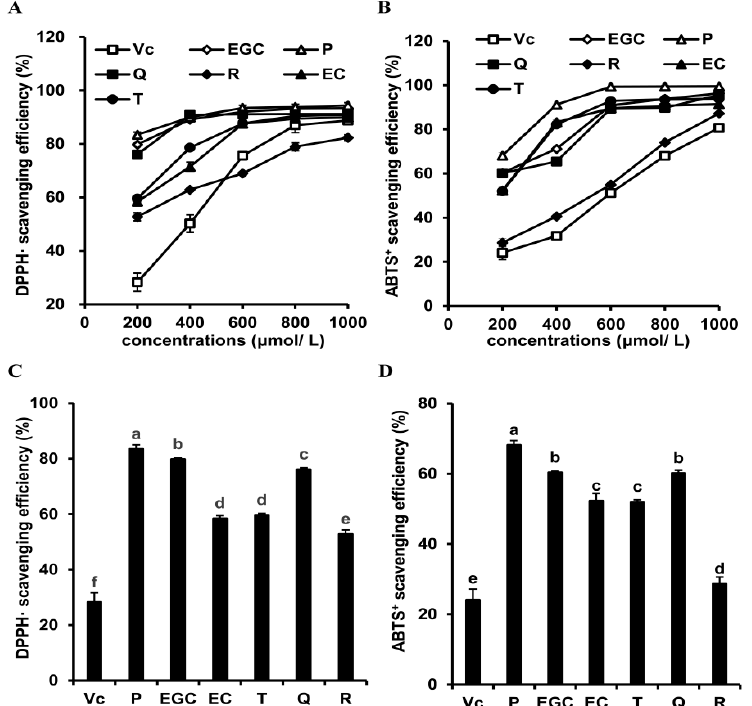
Figure 2. The in vitro antioxidant activities of the six flavonoids. ( A ) The 2,2-diphenyl-1-picrylhydrazyl (DPPH • ) scavenging activities of the six flavonoids at di ff erent concentrations; ( B ) The 2,2 (cid:48) -azino-bis-(3-ethylbenzothiazoline-6-sulfonic acid) (ABTS + ) scavenging activities of the six flavonoids at di ff erent concentrations; ( C ) The DPPH • scavenging activities of the six flavonoids at a concentration of 200 µ mol / L; ( D ) The ABTS + scavenging activities of the six flavonoids at a concentration of 200 µ mol / L. Vc, Vit. C group; EC, epicatechin group; EGC, epigallocatechin group; P, procyanidin B2 group; Q, quercetin group; T, taxifolin group; R, rutin group. Results are expressed as means ± SD. Values with di ff erent letters are significantly di ff erent ( p < 0.05).